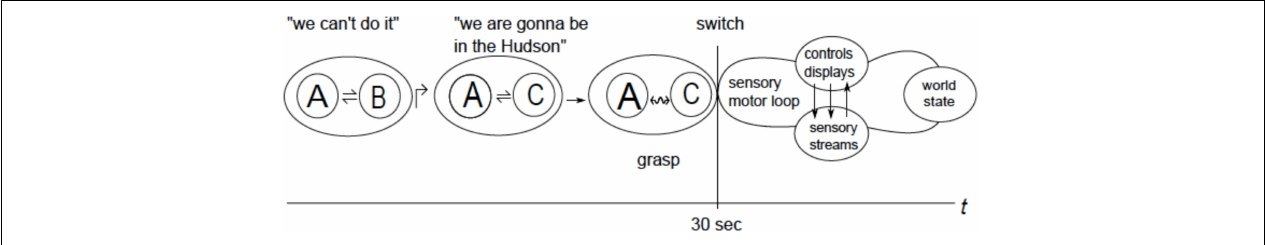
FIGURE 11 | Here A - aircraft, B - New Jersey airport, C - Hudson River. Mental operations are accompanied by imagery and remain decoupled from the motor-sensory feedback until, following grasp, the motor-sensory system gets